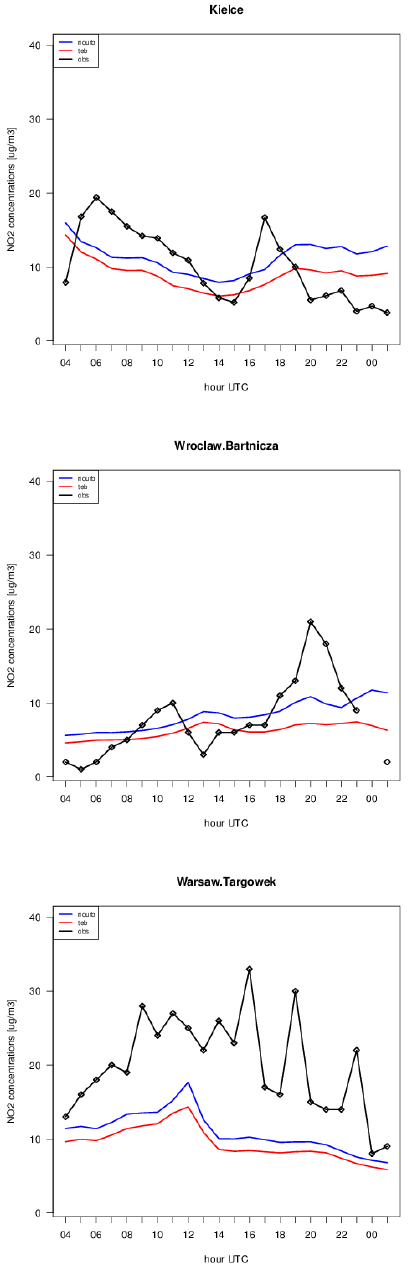
Figure 5 Comparison of modelled meteorological parameters with observations from Fig. 5. Comparison of modelled meteorological parameters with observations from Kielce station for 6 November 2010 (red line - Kielce station for 6 th of November 2010 (red line – urban scenario, blue line = non- urban scenario, blue line - non-urban scenario, black line - observa- tions). urban scenario, black - observations)